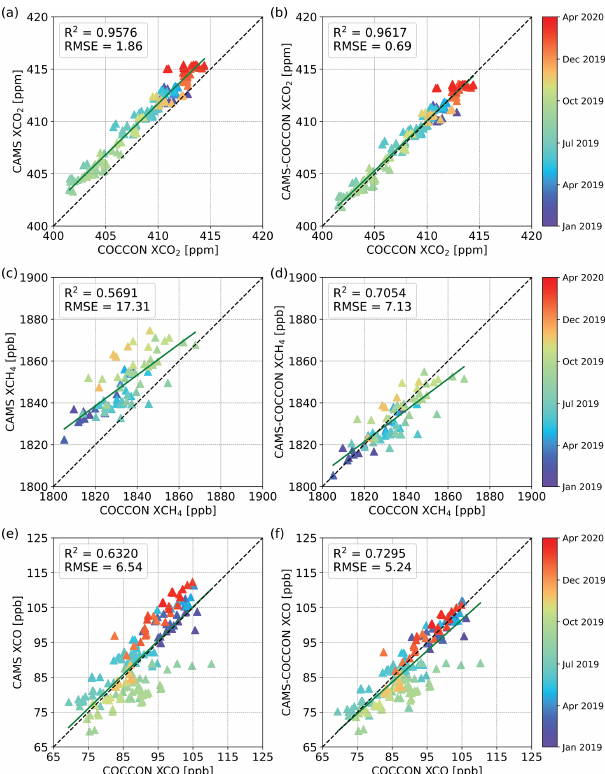
Figure A13. Correlation plots of CAMS (a, c, e) and CAMS- COCCON (b, d, f) with respect to COCCON for XCO 2 (a, b) , XCH 4 (c, d) and XCO (e, f) at